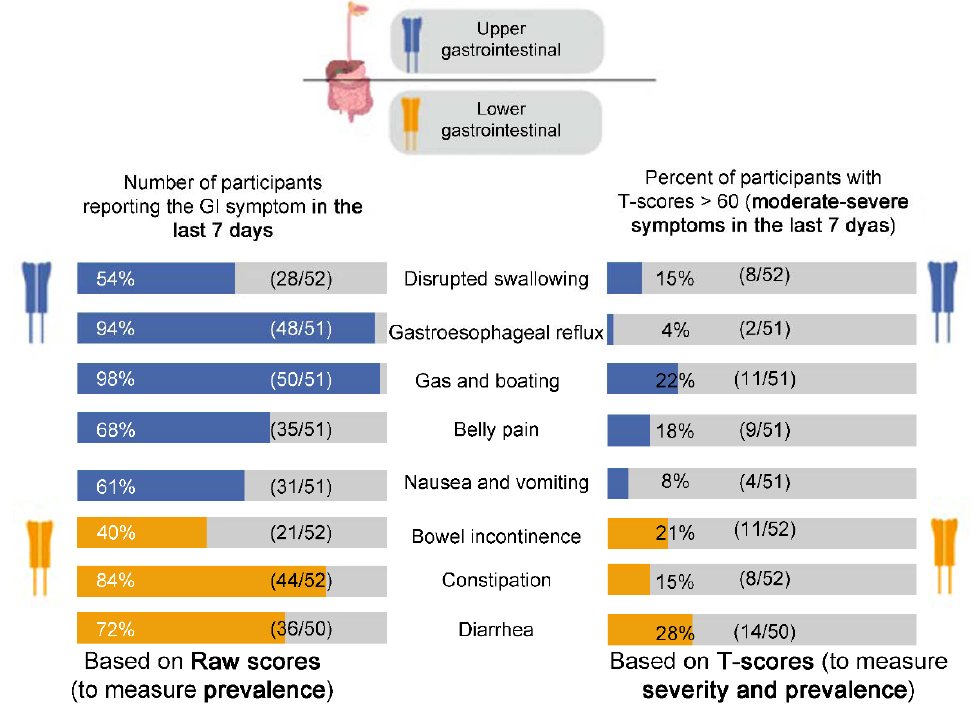
Figure 1. The prevalence and severity of gastrointestinal symptoms in adult patients with late-onset Pompe disease using PROMIS-GI symptom scales (This figure was created using BioRender.com; accessed on 5 January, 2021).